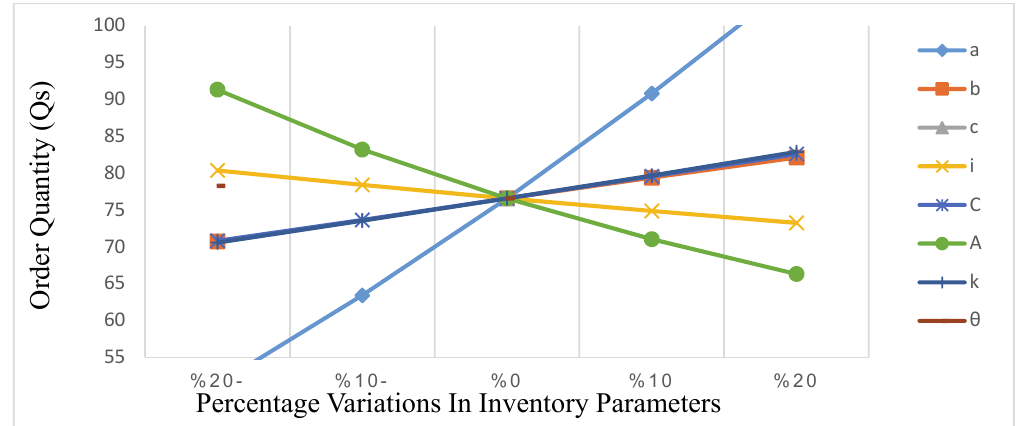
Fig. 6. Variations in order quantity